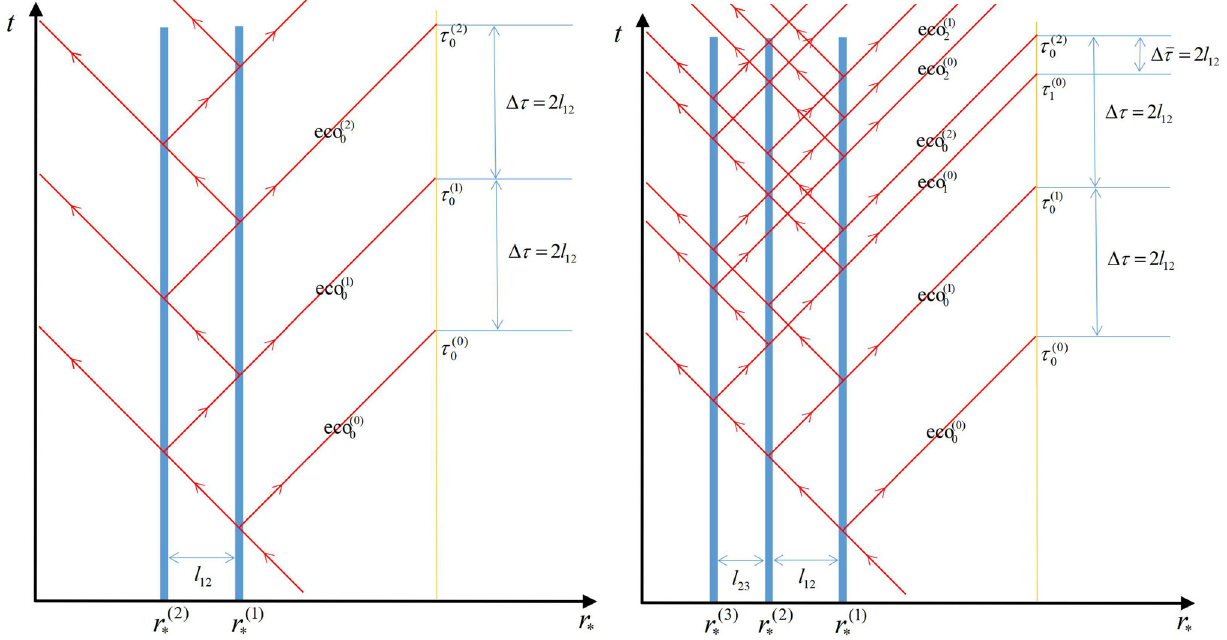
Fig. 5 The schematic diagram of echoes from a two-peaks potential case (left panel) and a three-peaks potential case (right panel). (Similar discussions are appeared in Refs.